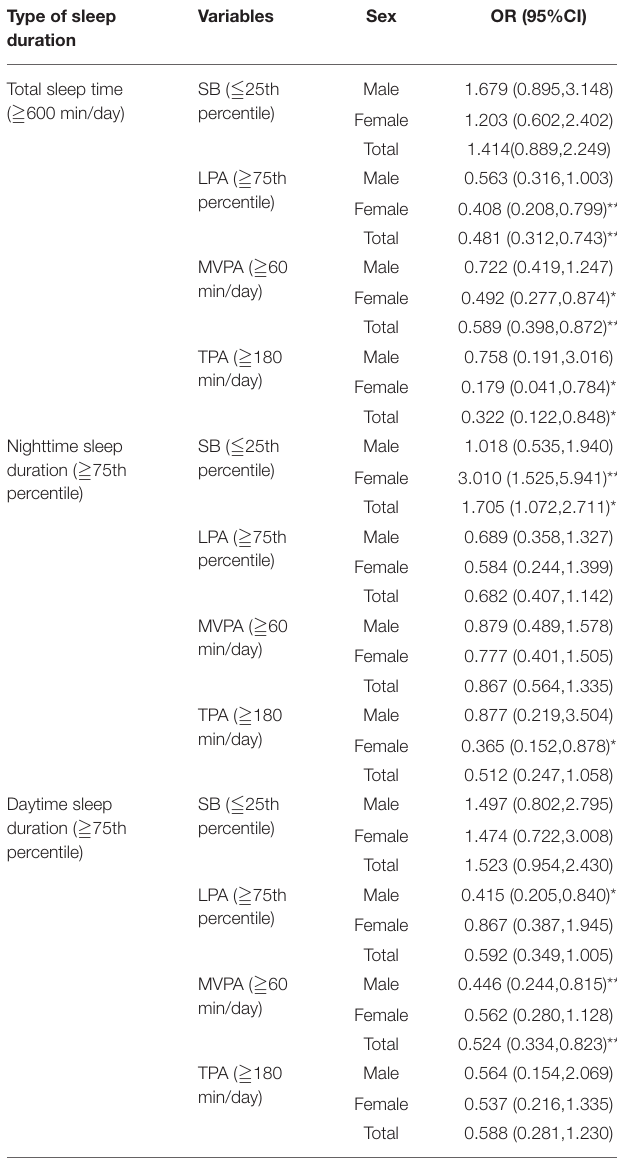
TABLE 4 | Protective and risk factors of adequate sleep for children of different